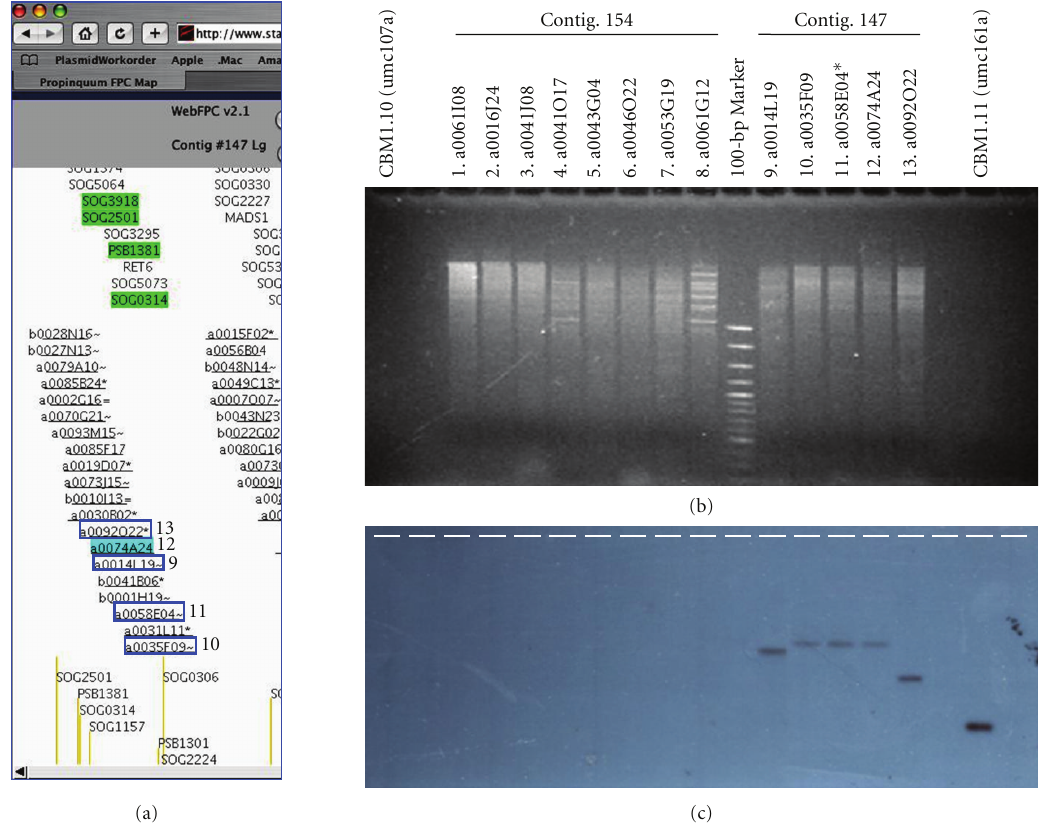
Figure 3: Southernblot confirmationof sorghumBACsafter filter hybridization. Step 5 (Table 2) ofthe BAC selection procedure is illustrated with CBM1.11 (umc161a). (a) Sorghum propinquum FPC contig map showing contig number 147 and the five contiguous BACs (boxed) detected by filter hybridization with the CBM1.11 probe. Lane numbers are indicated beside the BACs. (b) Ethidium bromide-stained agarose gel of Hin dIII-digested BAC minipreps. This gel includes the BACs under investigation (lanes 9–13) along with another set (lanes 1–8) serving as negative controls. For each confirmation blot, a positive control lane [CBM1.11 (umc161a)] is included. It contains a trace amount of the same insert preparation that was used in this experiment and in the preceding filter hybridization. (c) Autoradiograph after hybridization with the CBM1.11 probe. The asterisk indicates the BAC that was eventually selected as part of step 6 (Table